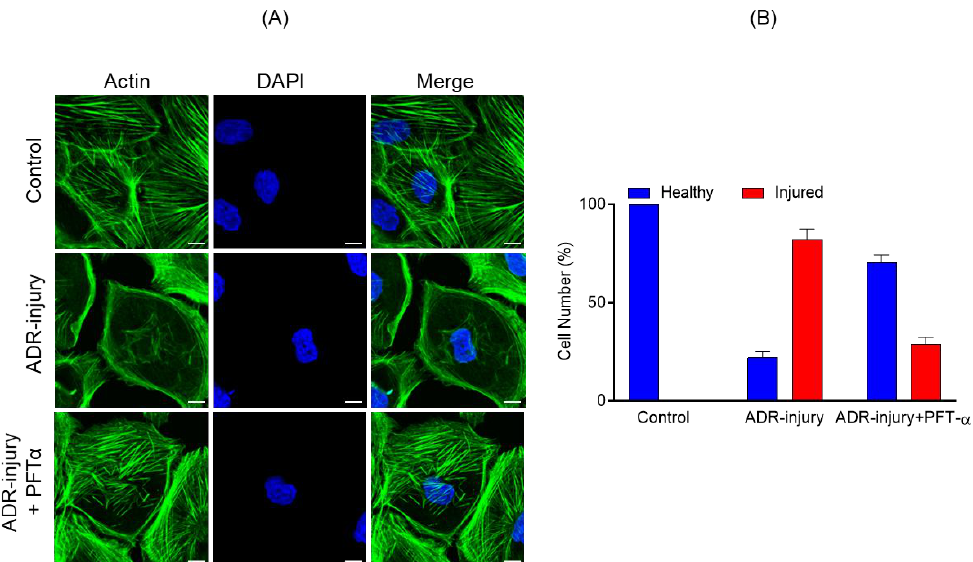
Figure 5. ( A ) Podocytes treated with ADR (0.25μg/mL) for 48 h showed significant actin cytoskeleton damage (green) with accumulation of actin stress fibers at the cell periphery. In contrast, significant recovery of actin cytoskeletal organization was noted in Pifithrin-α (PFT-α)-treated podocytes. Scale bar = 20 µ m. ( B ) The quantitative analysis showed > 50% increase in the number of healthy podocytes with a concomitant decrease in ADR injured podocytes upon PFT-α treatment; in contrast, minimal recovery was observed in the vehicle-treated podocytes.